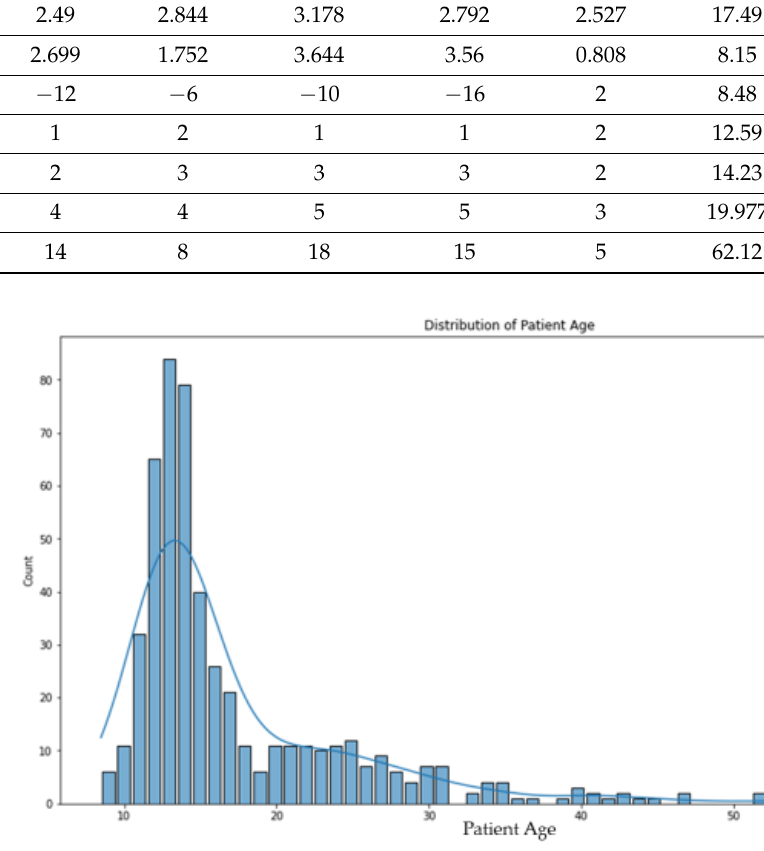
Figure 1. Histogram of patient age distribution.